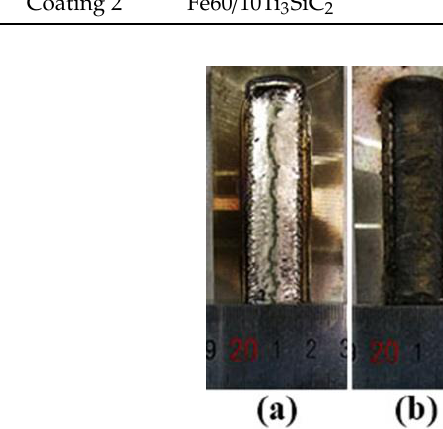
Table 2. The suitable process parameters and chemical compositions of preplaced powders. Samples